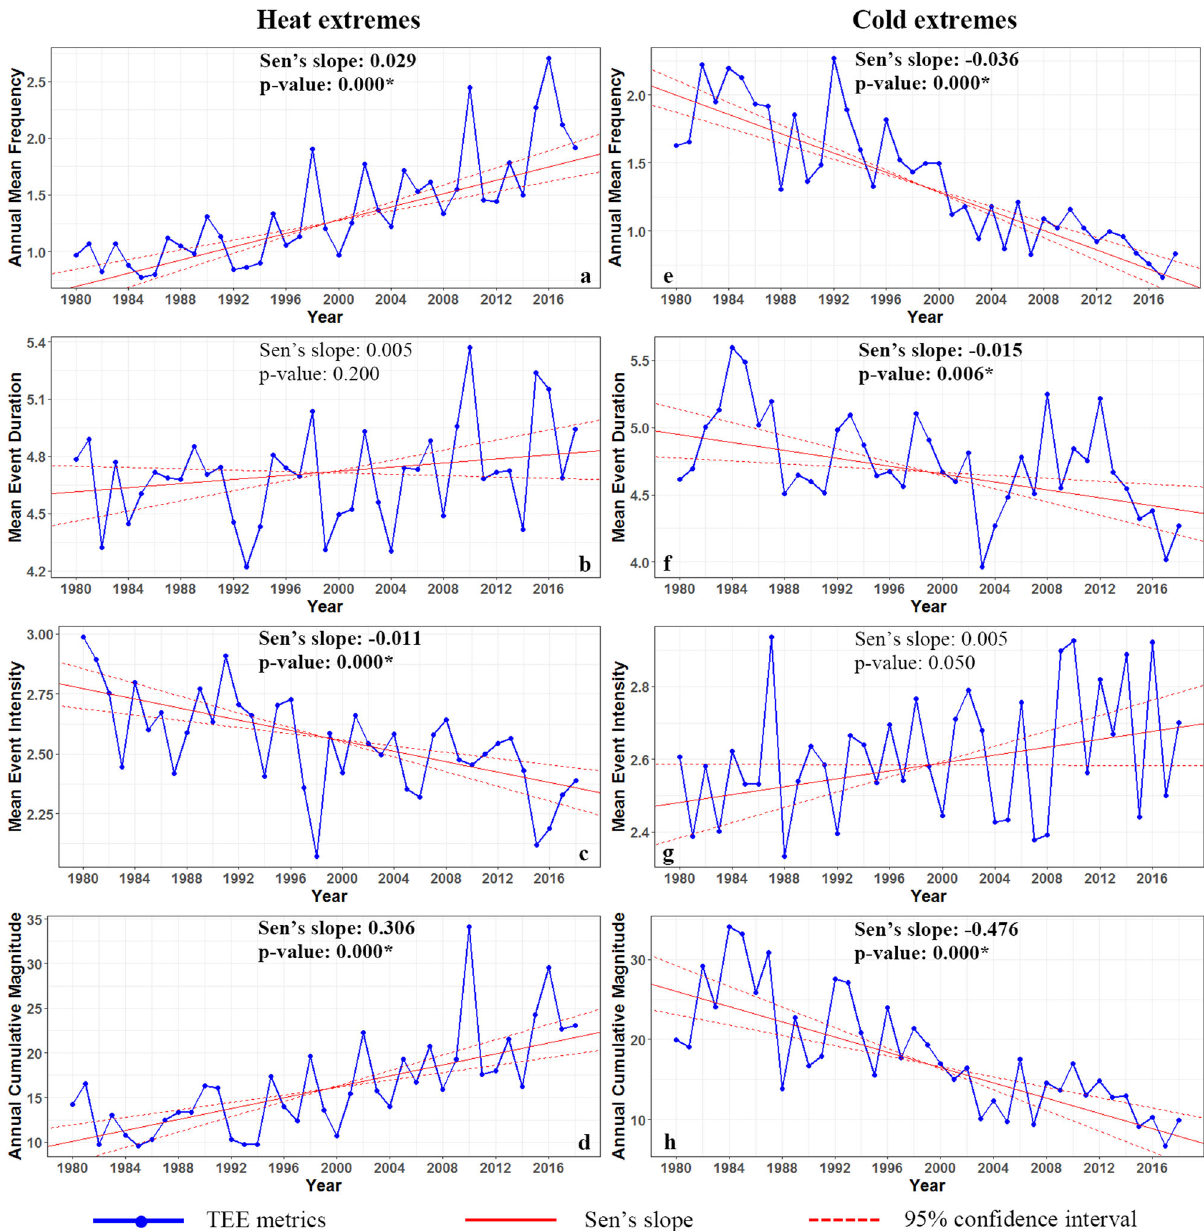
Fig. 4 Global trends of heat and cold extremes. a – d Trends of annual mean frequency ( F ), mean event duration ( D ), mean event intensity ( I ) and annual cumulative magnitude ( M ) for heat extremes. e – h Trends of F, D , I and M for cold extremes. Trends were estimated for 1980 – 2018 using Mann – Kendall test and Theil – Sen method, and signi fi cant trends at the 5% level were marked with * and in